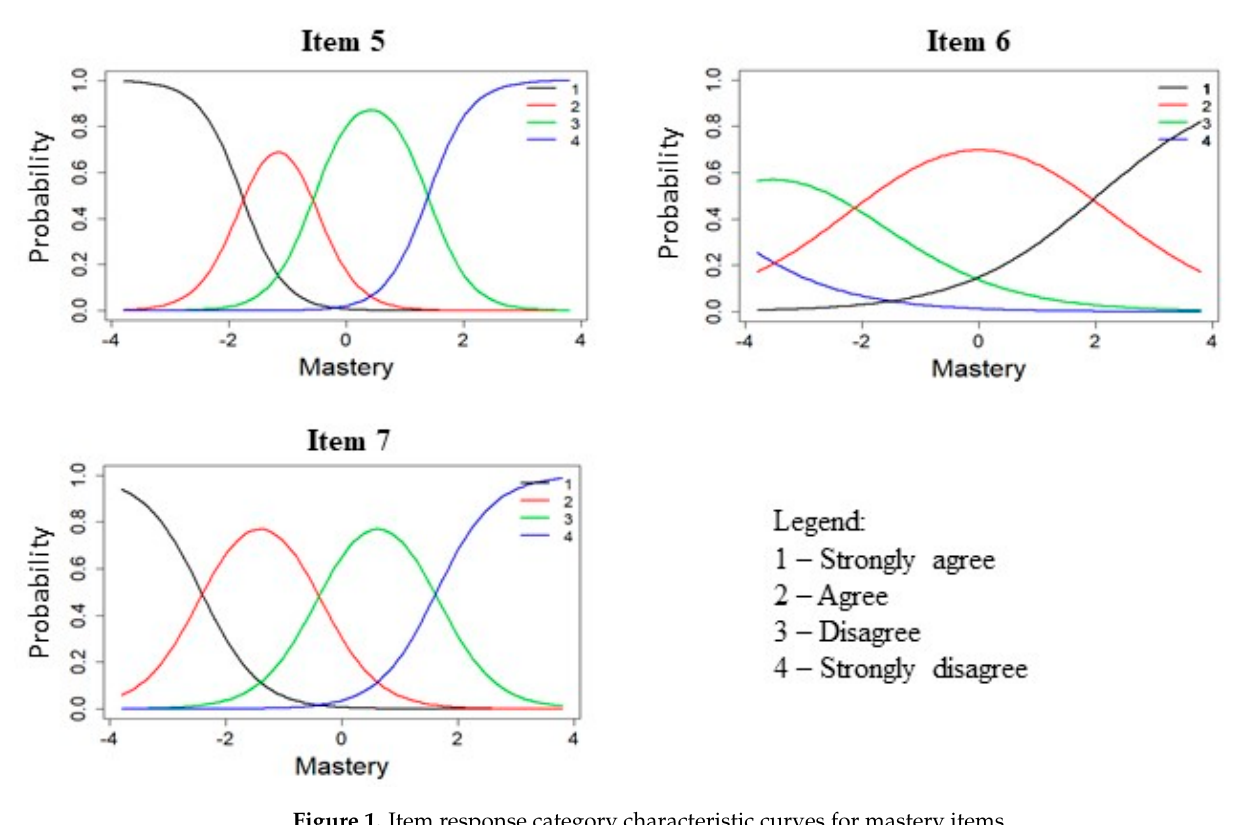
Figure 1. Item response category characteristic curves for mastery items.